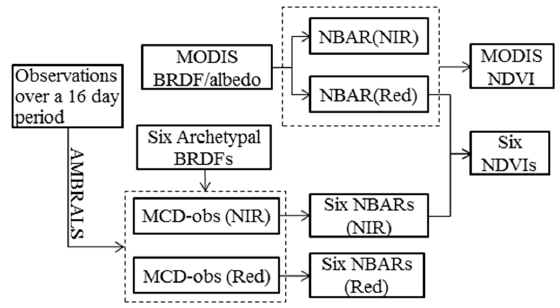
Figure 2. Flowchart of the retrieval and comparison of the NBARs and NDVIs.